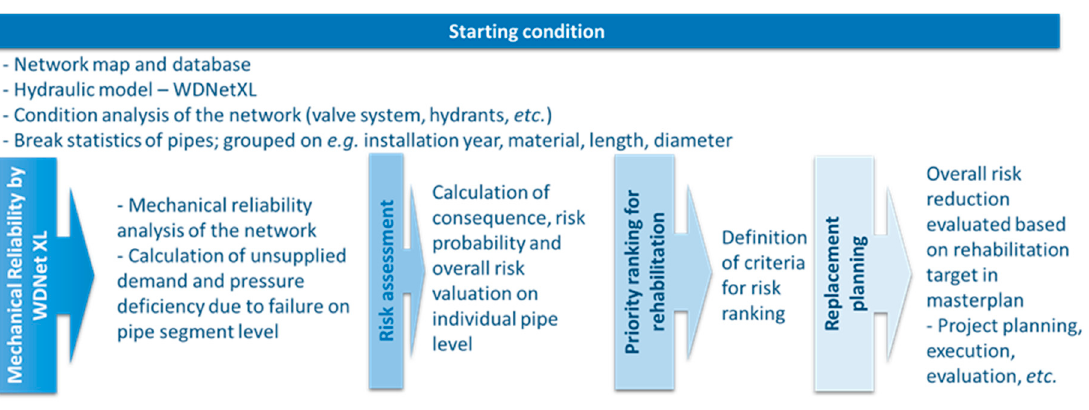
Figure 1. Methodology of reliability-based risk assessment proposed by this study